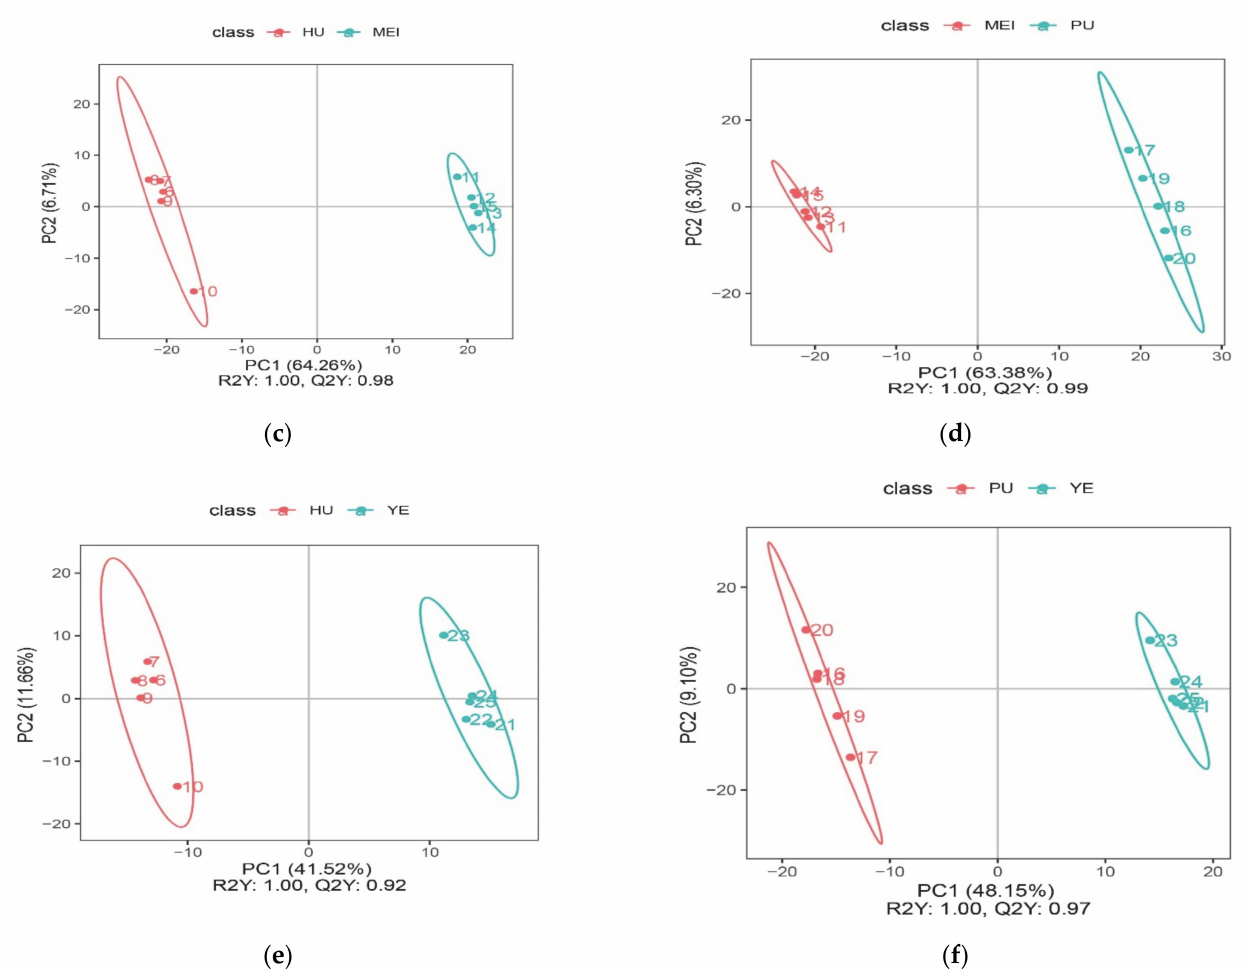
Figure 3. The VOC metabolic variation between aromatic and non-aromatic rice varieties. ( a ) PLS-DA scores plot of Daohuaxiang 2 vs. Huanghuazhan. ( b ) PLS-DA scores plot of Daohuaxiang 2 vs. Yanfeng 47. ( c ) PLS-DA scores plot of Meixiangzhan 2 vs. Huanghuazhan. ( d ) PLS-DA scores plot of Meixiangzhan 2 vs. Yanfeng 47. ( e ) PLS-DA scores plot of Yexiangyoulisi vs. Huanghuazhan. ( f ) PLS-DA scores plot of Yexiangyoulisi vs. Yanfeng